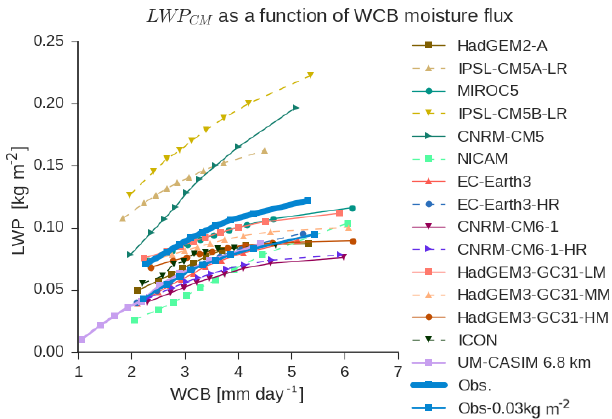
Figure 1. Cyclone-mean LWP (LWP CM ) as a function of the WCB moisture flux in models and observations. LWP CM is shown aver- aged into nine equal quantiles for the observations and each GCM. The maximum bias in the observations ( ∼ 0 . 03kgm − 2 ) is shown by a lighter blue